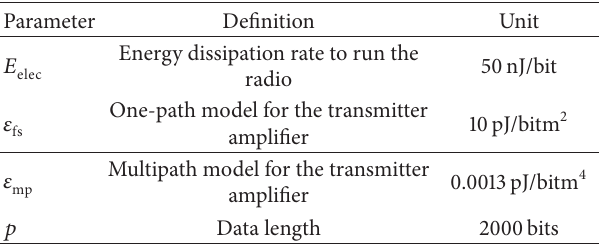
Table 1: The definition of all of the ratio parameters